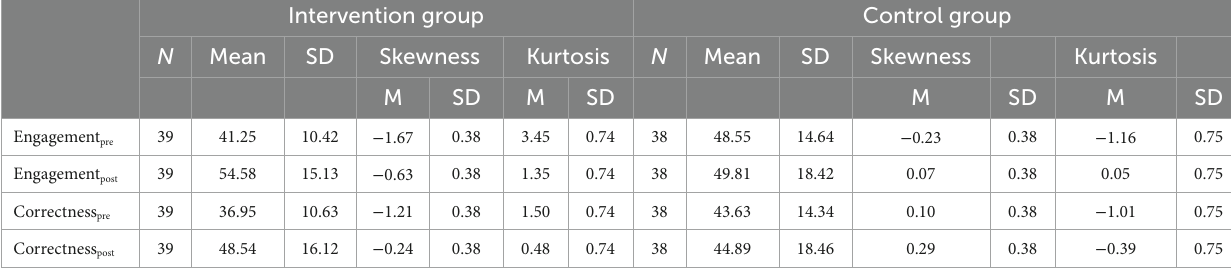
TABLE 1 Descriptive Statistics (Mean, standard deviation, skewness, and